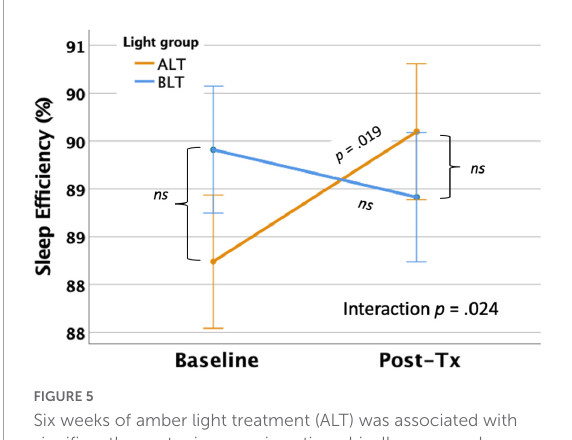
FIGURE5 Six weeks of amber light treatment (ALT) was associated with significantly greater increase in actigraphically measured percentage sleep efficiency (SE) than an equal period of blue light treatment (BLT), p = 0.024. Orange line = ALT; Blue line = BLT. Error bars = ± 1 SE. Post hoc comparisons are Bonferroni